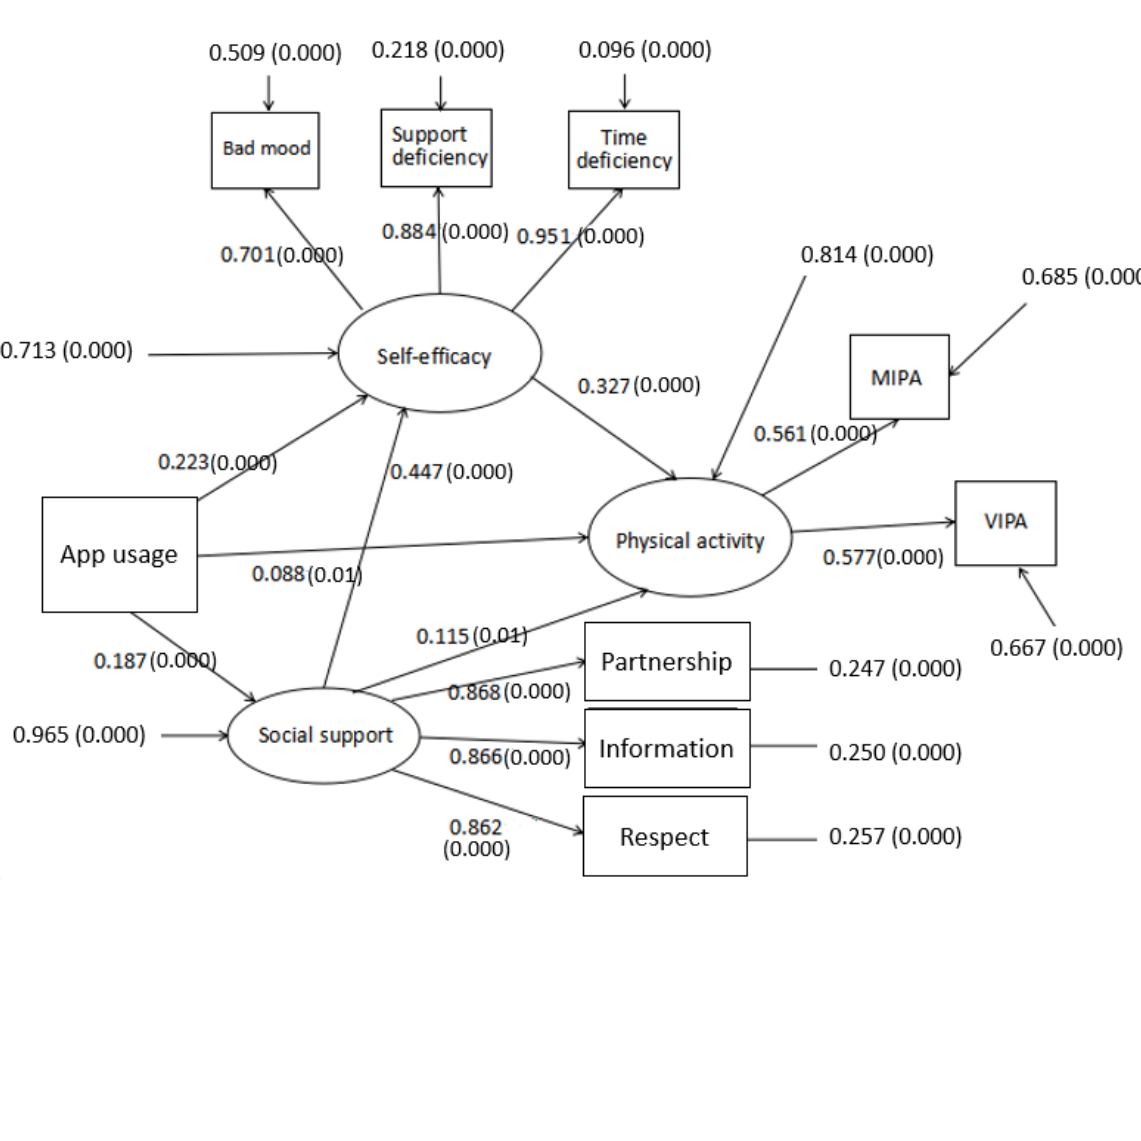
Figure 3. Multi serial mediator model, in which social support is described by three manifest indicators (partnership support, information support, and respect support). Self-efficacy is described by bad mood, support deficiency, and time deficiency; VIPA is vigorous-intensity physical activity and MIPA is moderate-intensity physical activity. (0.000) represents significant path coefficients at the .001 level and (0.01), at the .05